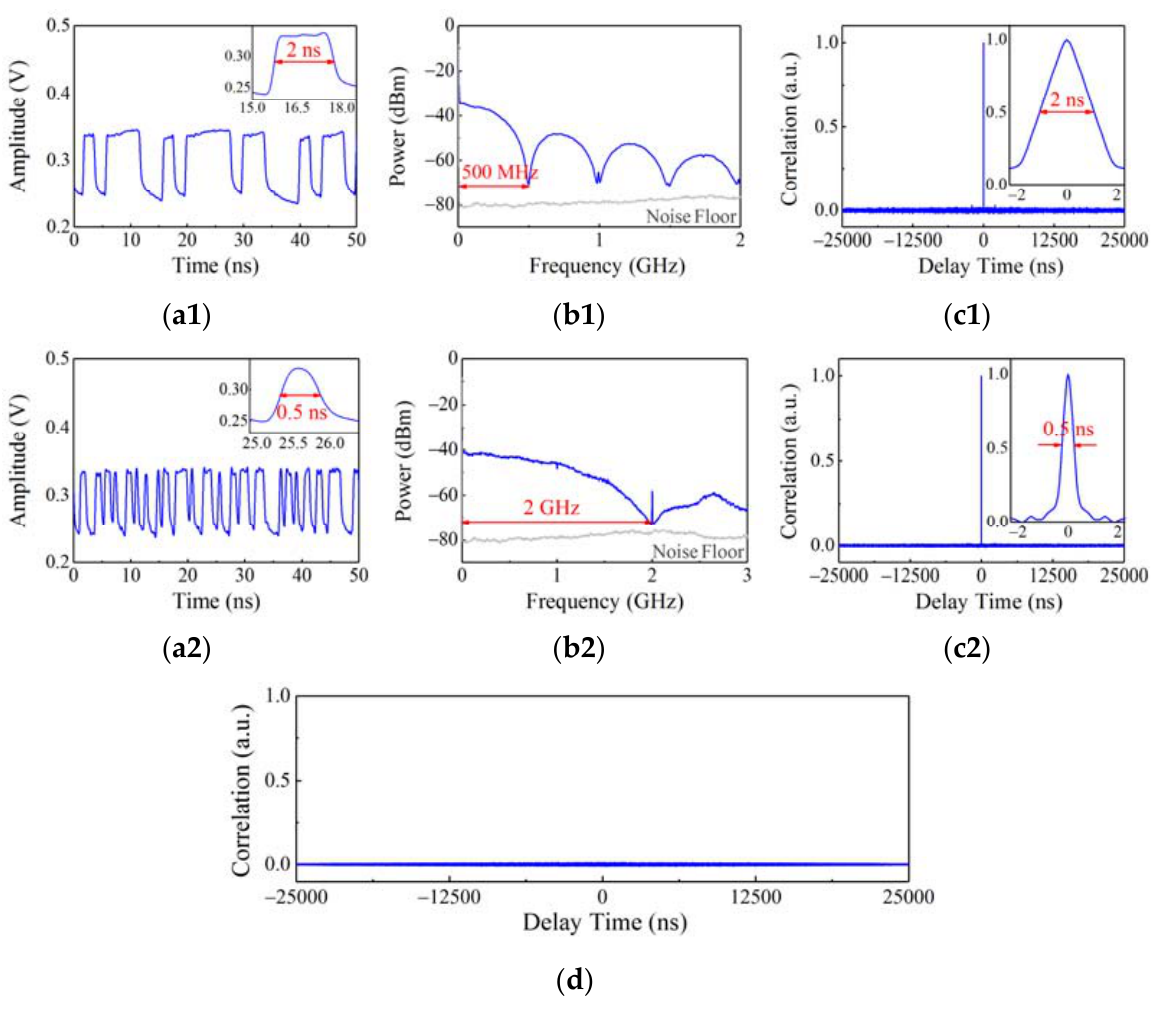
Figure 4. ( a1 ), ( a2 ) Time-domain waveforms; ( b1 ), ( b2 ) power spectrums; ( c1 ), ( c2 ) auto-correlation traces of the 500 Mbps and 2 Gbps random code signals; and ( d ) their cross-correlation trace.